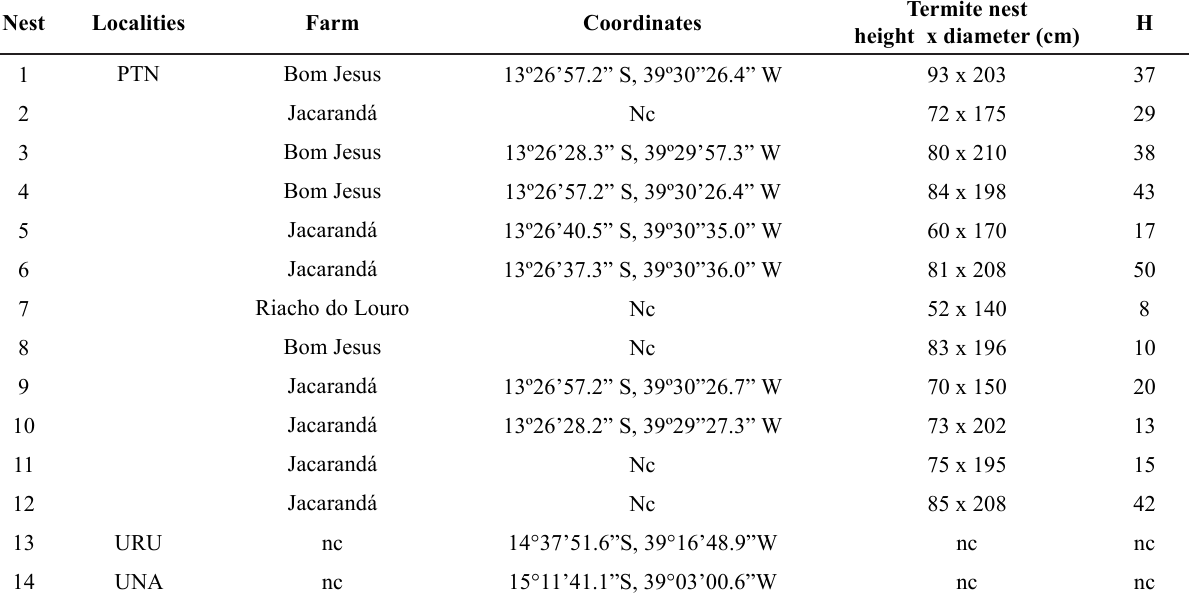
Table 1 . Partamona ailyae Camargo nests sampled in municipality of Presidente Tancredo Neves (nests 1-12) in south lowlands, state of Bahia, and municipalities of Uruçuca and Una (nests 13-14) in southern portion of state of Bahia. Some nest characteristics are presented. “H” = height of nest entrance in the termite nest. nc = non-collected